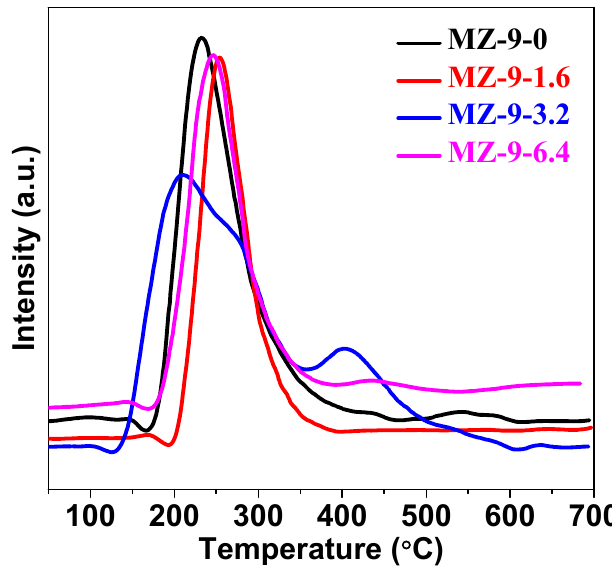
Figure 9. NH 3 -TPD spectra of MZ-9-0, MZ-9-1.6, MZ-9-3.2, and MZ-9-6.4.